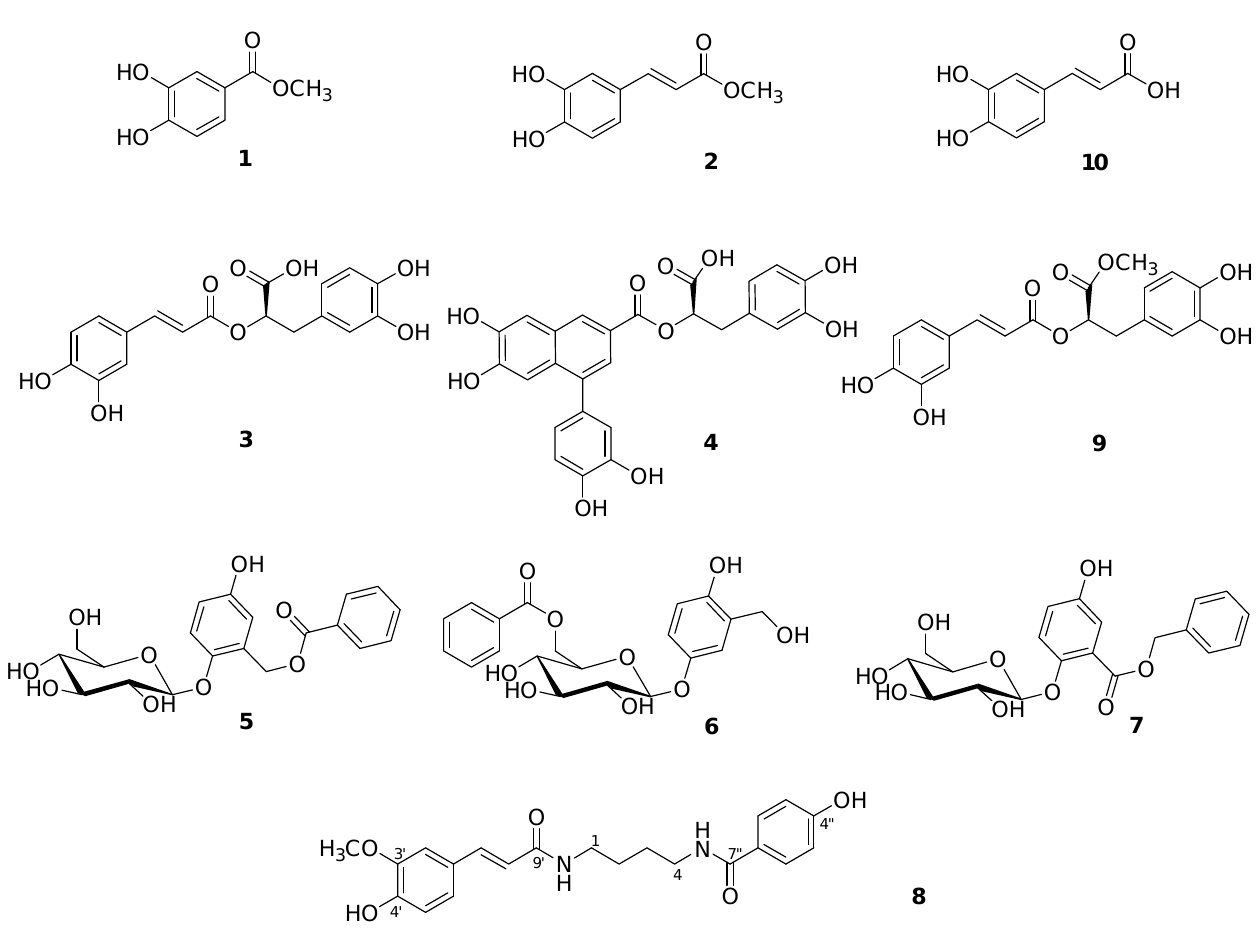
Figure 1. The structures of the isolated compounds 1 - 10 from P. verticillata